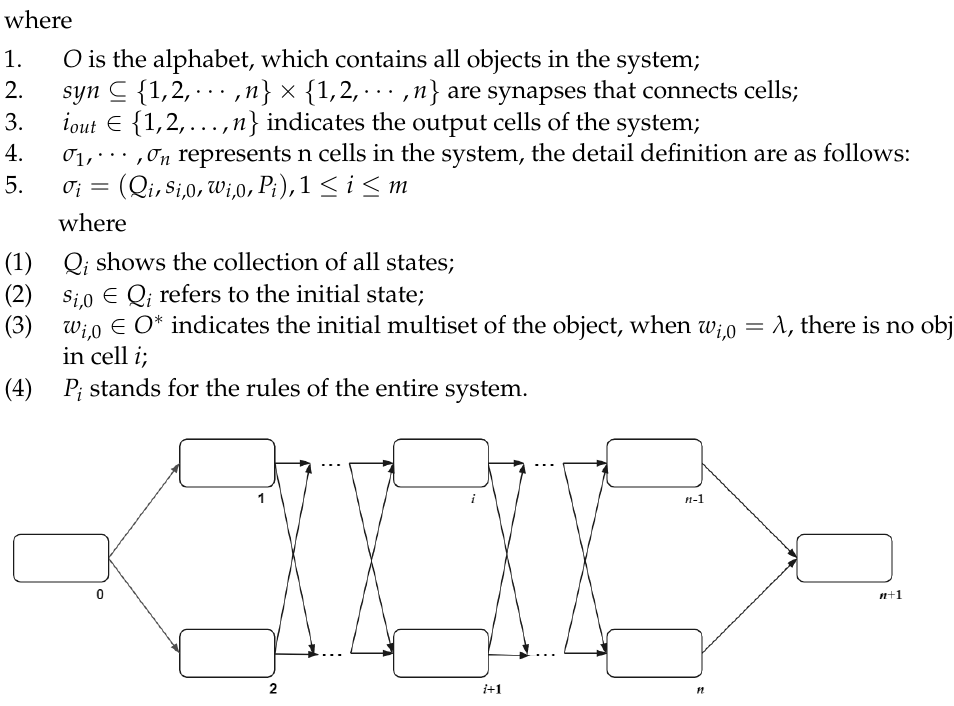
Figure 2. The basic membrane structure of the tissue-like P system.